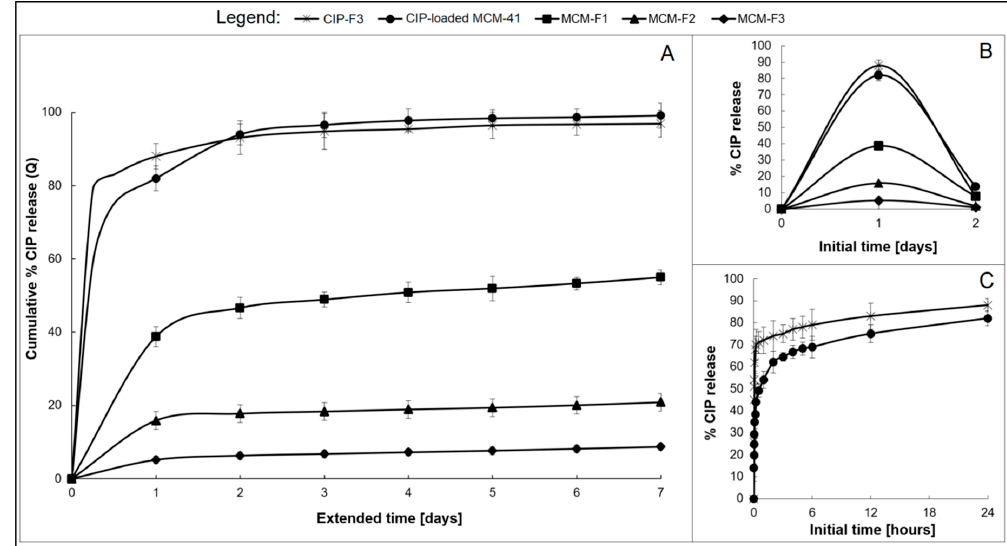
Figure 6. The overall CIP release profiles from MCM-F1, MCM-F2, MCM-F3, CIP-F3 solid films, and CIP-loaded MCM-41 ( A ); Insets: not-cumulative CIP release during the initial time: 0–2 days; ( B ) and initial 24 h CIP release from CIP-loaded MCM-41 and CIP-F3 ( C ).